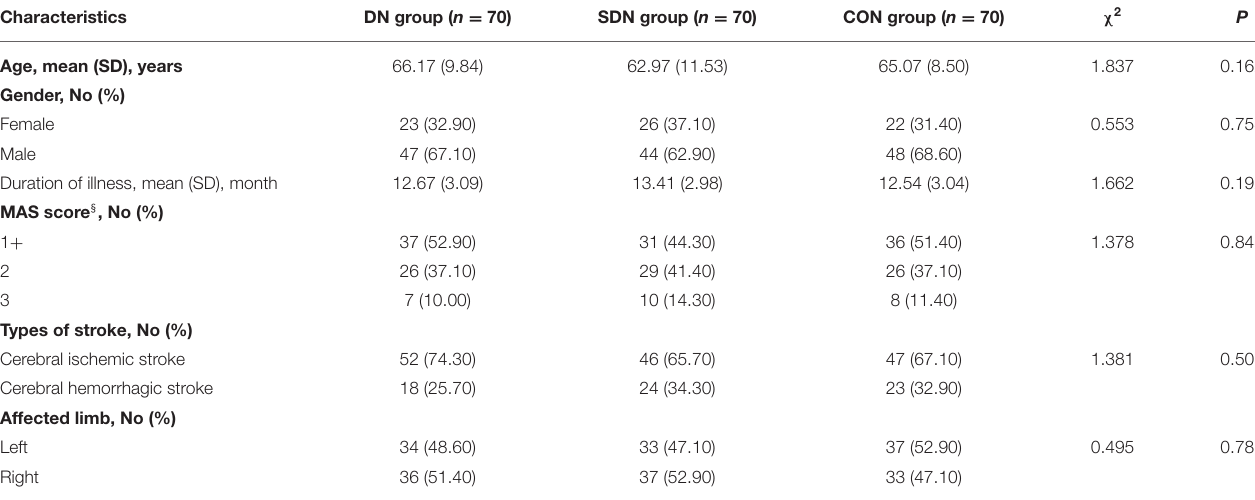
TABLE 1 | Baseline characteristics.